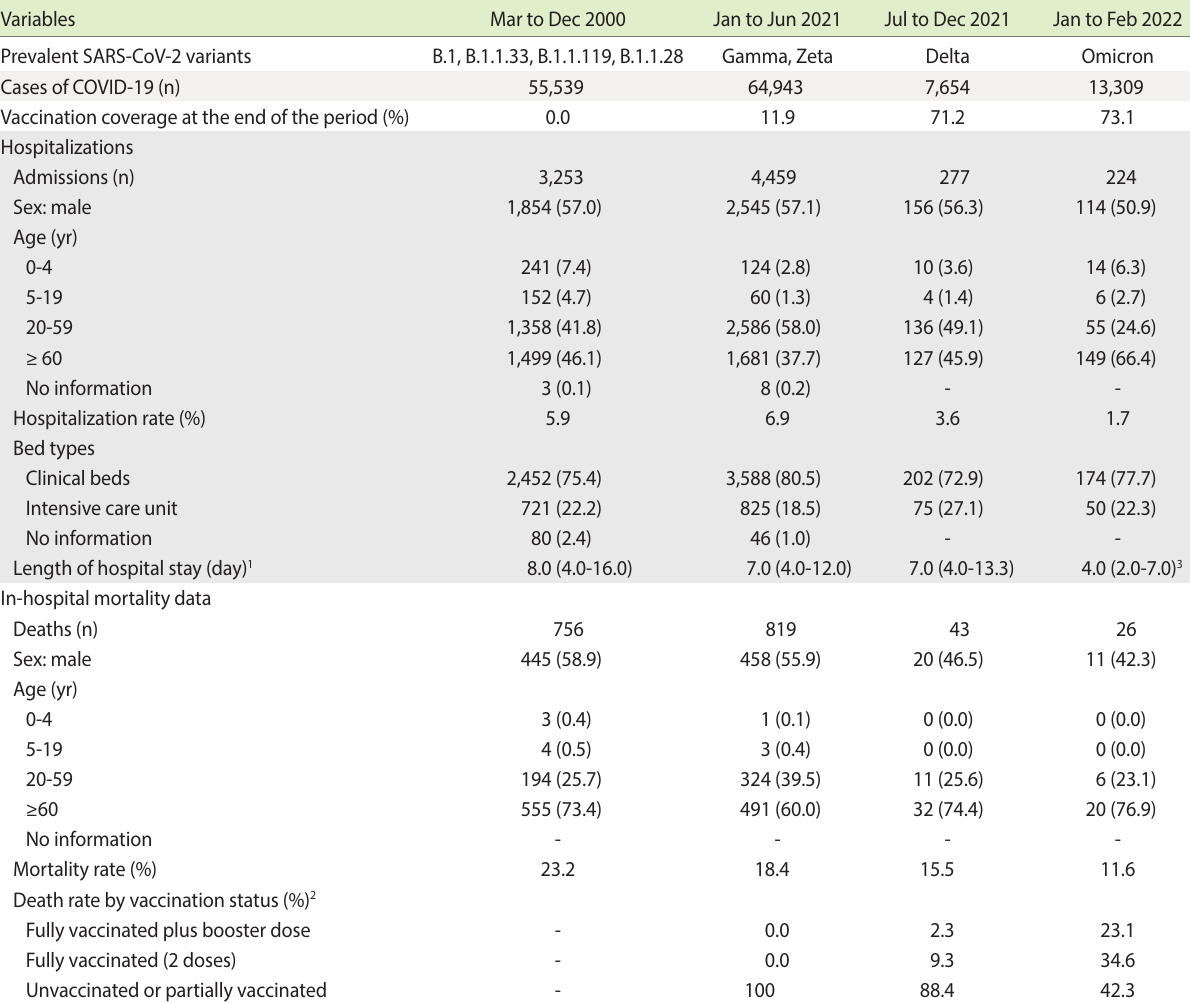
Table 1. Clinical data and distribution of hospitalizations and deaths of patients with COVID-19 throughout the pandemic